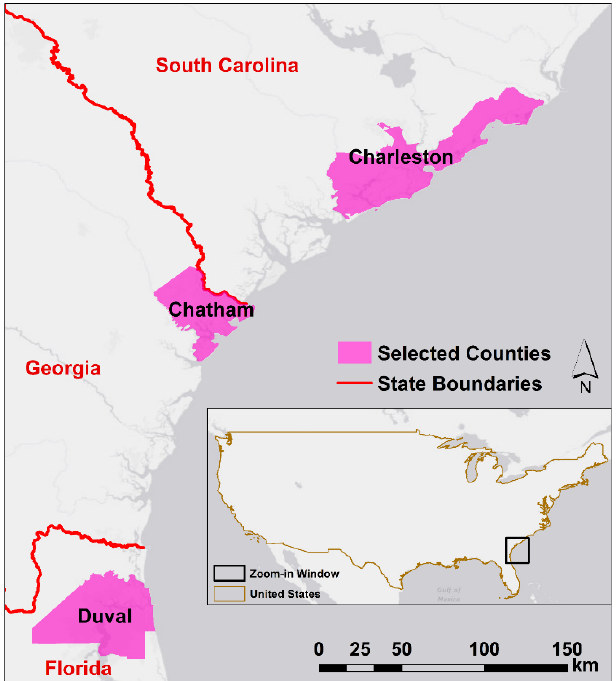
Figure 1. The study area consists of three coastal counties in the southeastern US, which are Charleston, SC, Chatham, GA, and Duval, FL. (The World Light Gray Basemap is used as the background, which is provided by Esri, HERE, Garmin, © OpenStreetMap contributors, and the GIS User Community.)